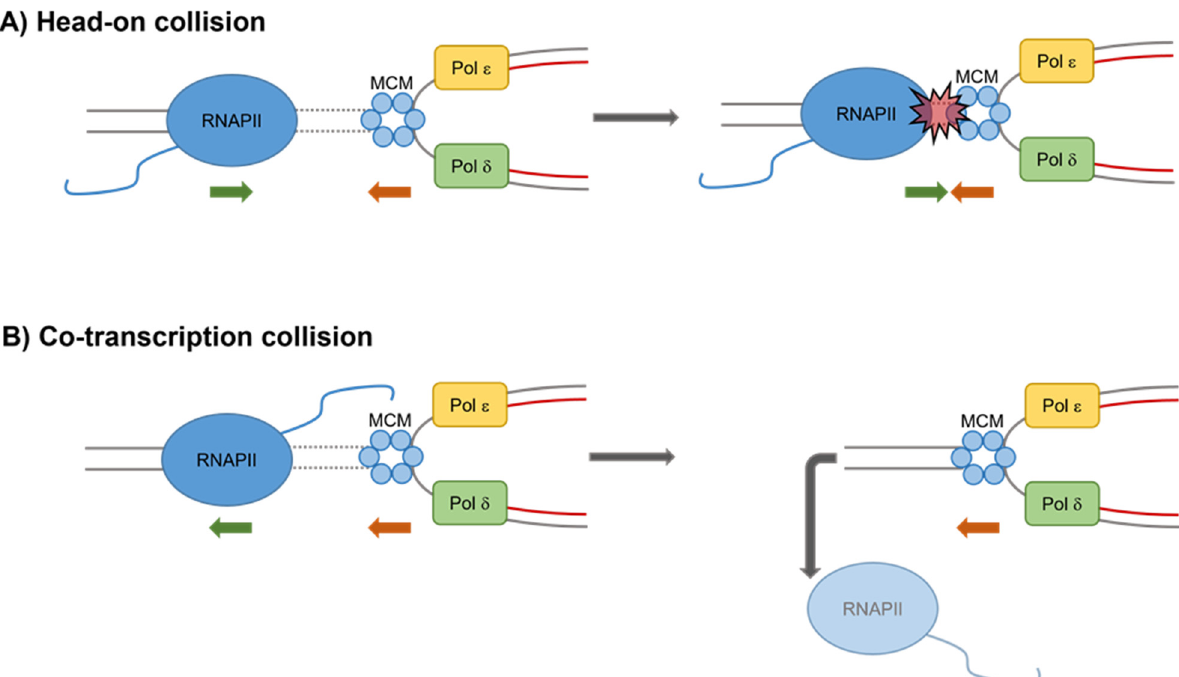
Figure 1. Head-on and co-directional transcription–replication collisions. ( A ) Head-on collisions are generated by progression in opposite directions of an RNA polymerase (RNA pol) and a replication fork. This leads to pausing and arrest of the replication fork that can result in fork collapse and DSBs formation. ( B ) Co-directional collisions occur when progression of an RNA pol and a replication fork are in the same direction and fork moves more quickly than the RNA pol. Displacement of the RNA pol from the DNA is required to resolve these collisions. MCM, mini chromosome maintenance complex; Pol δ , DNA polymerase δ ; and Pol ε , DNA polymerase ε .